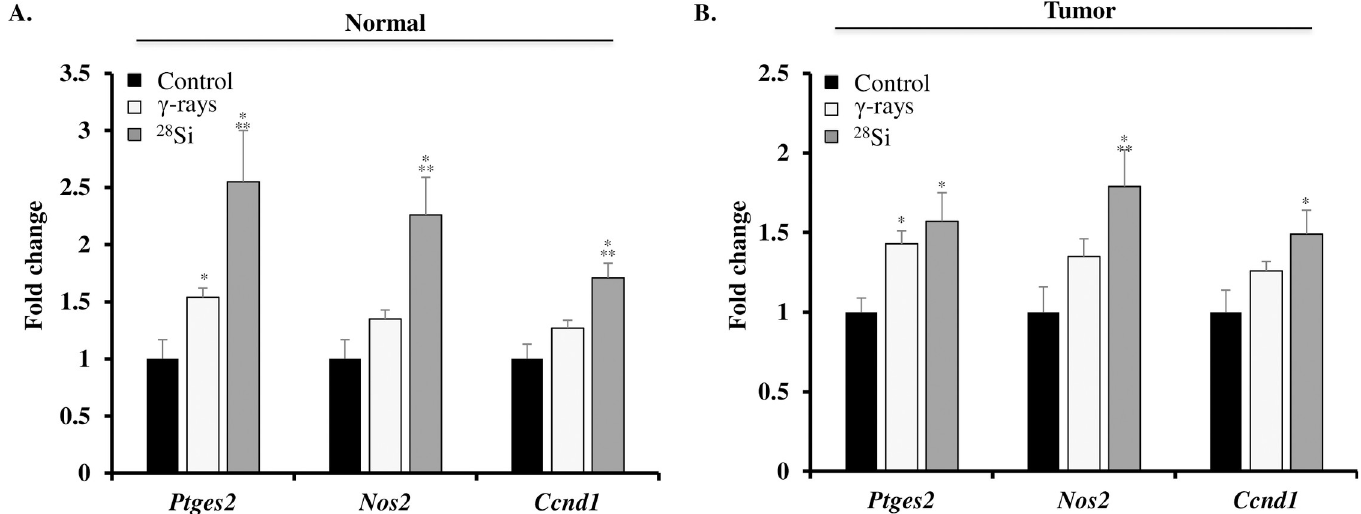
Fig 5. Increased expression of β -catenin and NF- κ B target genes in heavy-ion exposed mouse colon. A) Fold change in expression of β -catenin and NF- κ B target genes (Ptges2 , Nos2 , and Ccnd1) in normal colonic mucosa. B) Fold change in expression of β -catenin and NF- κ B target genes (Ptges2 , Nos2 , and Ccnd1) in colon tumor. All bars show mean ± SEM and � indicates a p < 0.05 compared to control and �� indicates p < 0.05 compared to the γ exposed